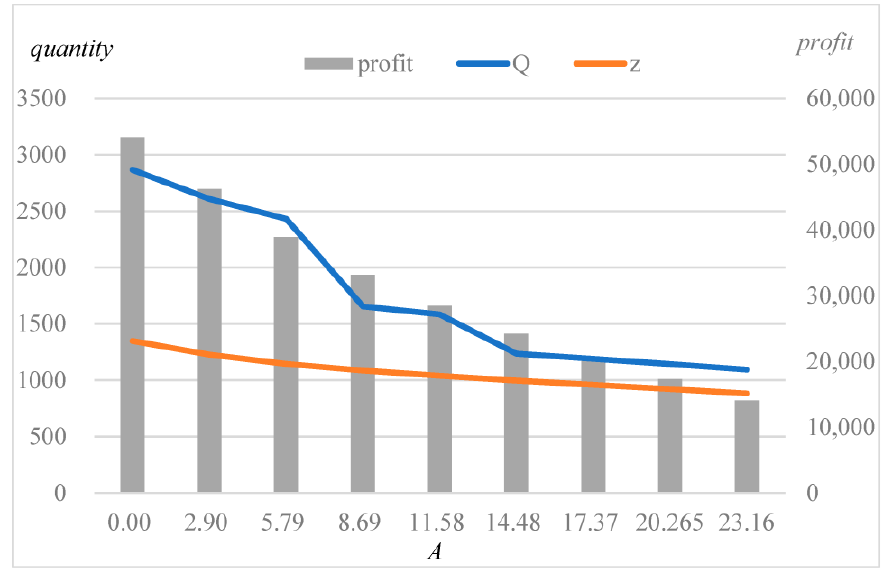
Figure 3. The result for various unit acquisition costs A .